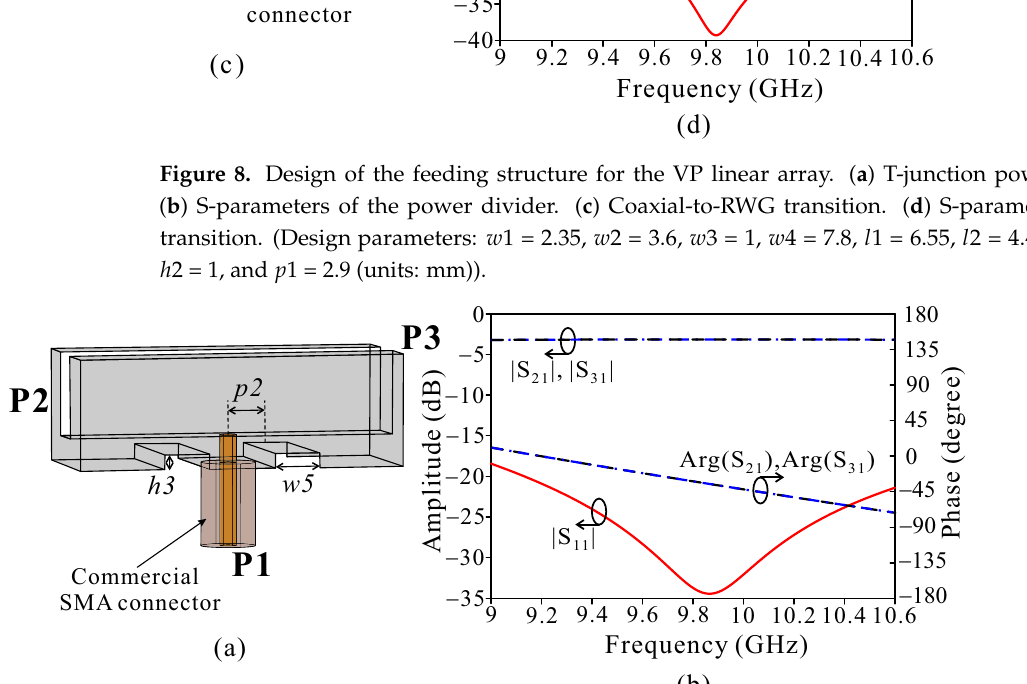
Figure 9. Design of the feeding structure for HP linear array. ( a ) Coaxial-to-RWG transition. ( b ) S-parameters of the transition. (Design parameters: w 5 = 2.75, p 2 = 3.425, and h 3 = 1 (units: